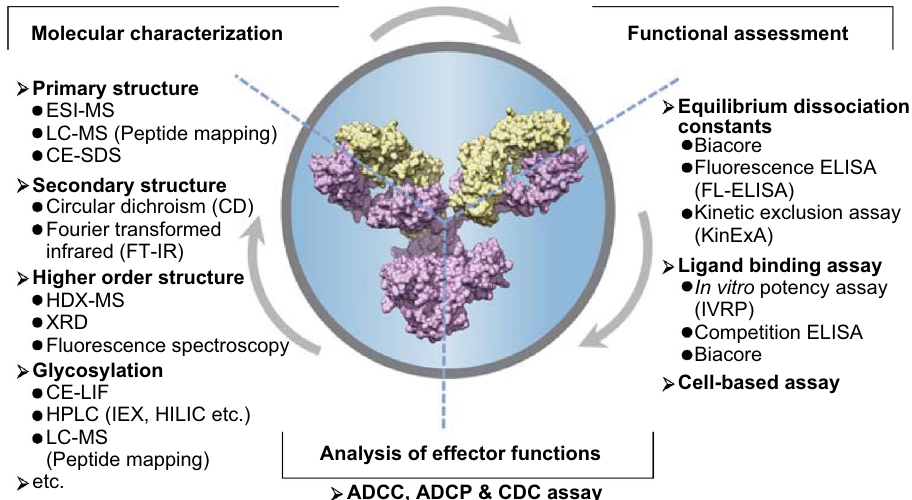
Figure 1. Overview of the methods of molecular structural analysis and functional assessment. As a complex macro-molecule protein, the molecular characteristics and functions are critical quality attributes for monoclonal antibodies. A series of physicochemical and biological methods are developed to evaluate these critical quality attributes carefully. In addition to the general molecular characterization, the function-associated analyses are listed in the right panel and bottom panel. The example monoclonal antibody is a representative IgG1 (PDB: